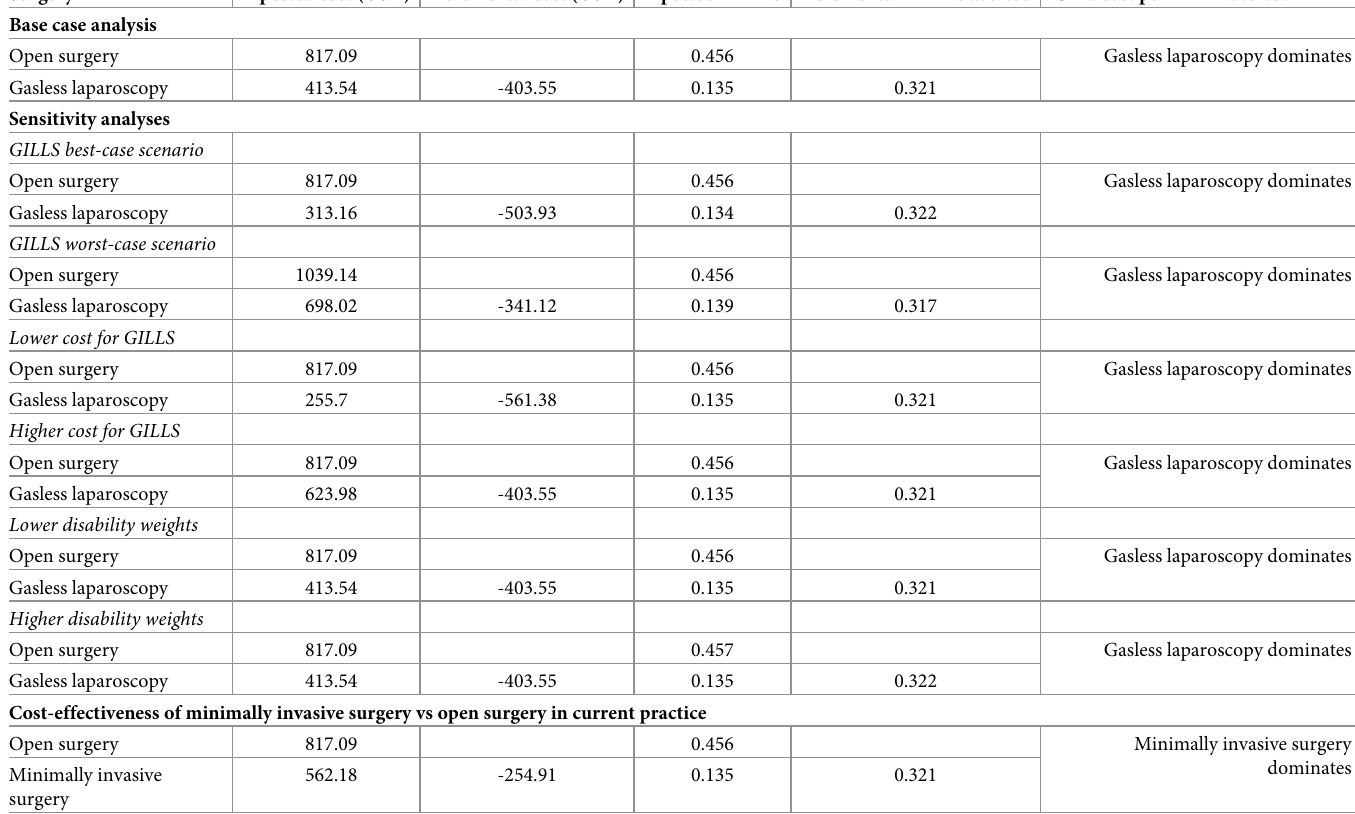
Table 3. Cost-effectiveness